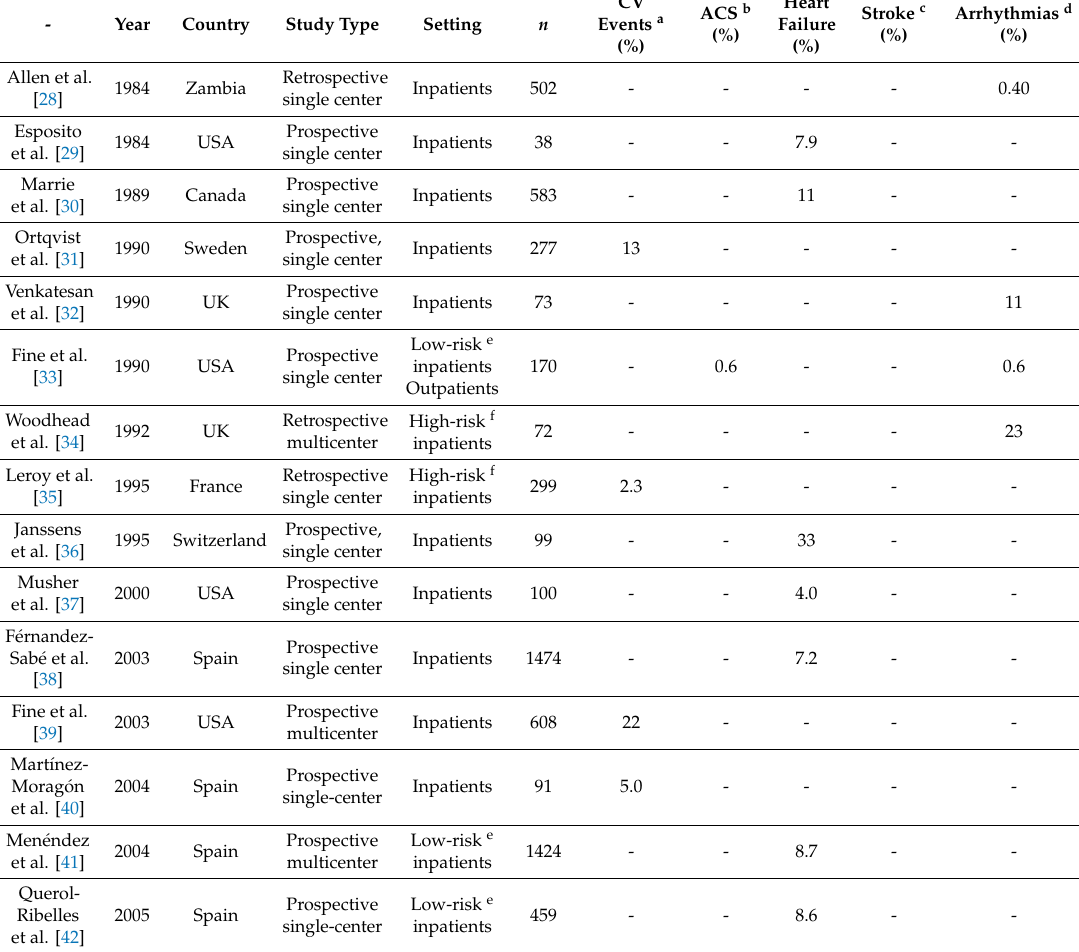
Table 1. Characteristics of included